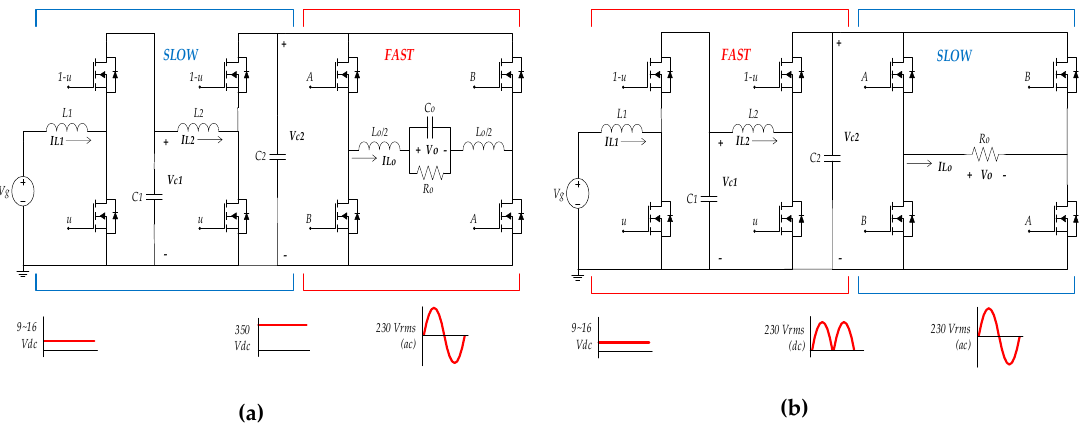
Figure 4. Strategies to perform a step-up inverter based on a two cascaded-boost converter: ( a ) conventional approach (slow-fast), ( b ) proposed approach (fast-slow).